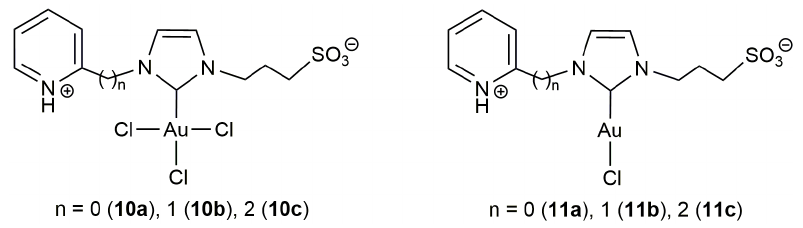
Figure 3. Structure of the zwitterionic Au(III)- and Au(I)-NHC complexes 10,11a – c .